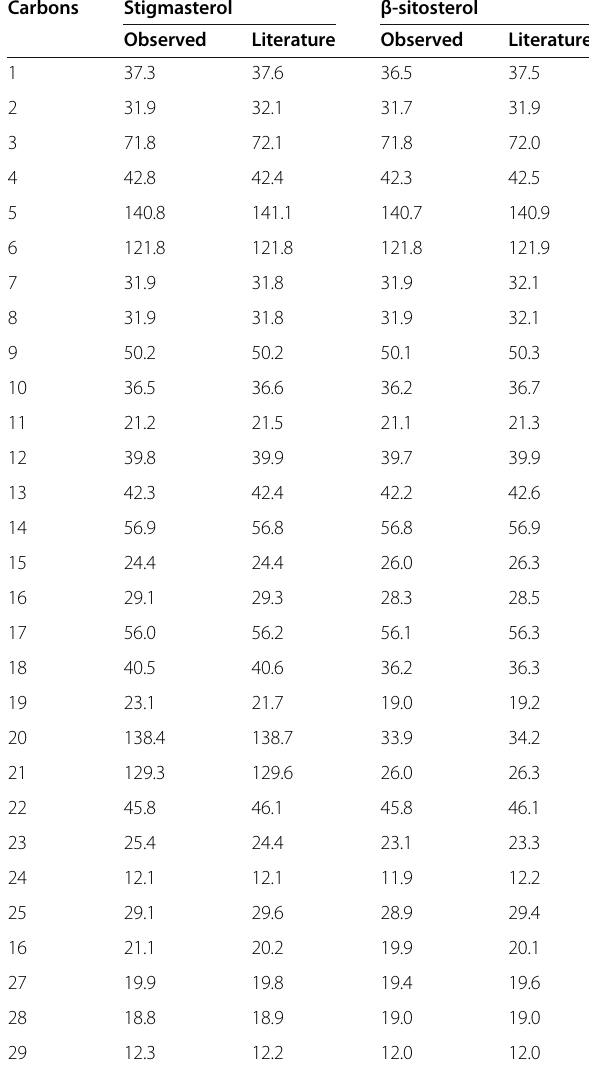
Table 1 13 C NMR chemical shift values (ppm) of stigmasterol and β -sitosterol recorded in CDCl